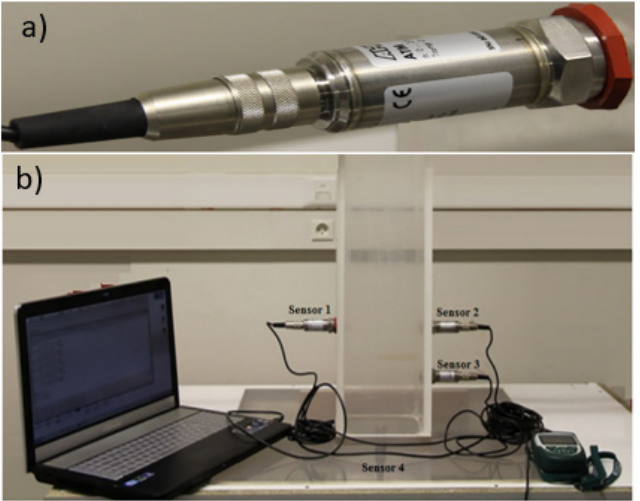
Figure 8. Laboratory setup. ( a ) Flush diaphragm sensor. ( b ) Laboratory setup for pressure monitor- ing [11] (reprinted with permission from © 2021 Elsevier Ltd.).